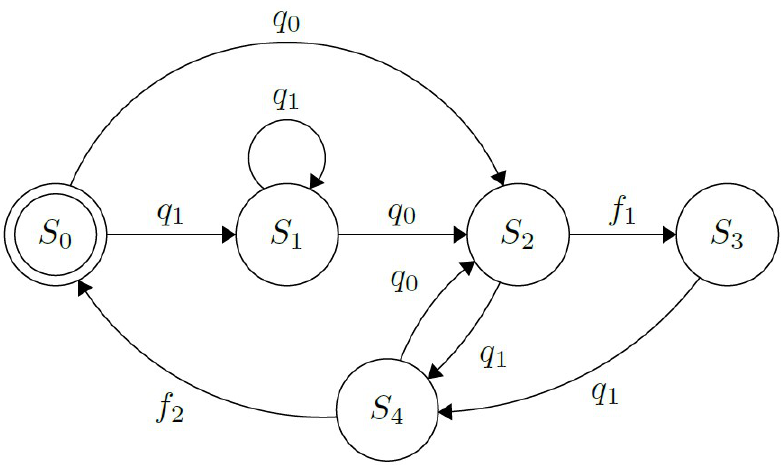
Figure 7. Finite State Machine representing the UPI interaction process from the version with the reduced contraction subset. S 0 indicates that the hand is completely open; S 1 , that there was a change in the selected grip; S 2 , that the selected grip is being performed (when it is completed, the flag f 1 is lifted). In addition, S 3 represents that the hand is currently enacting the chosen gesture; while, S 4 , that the fingers are